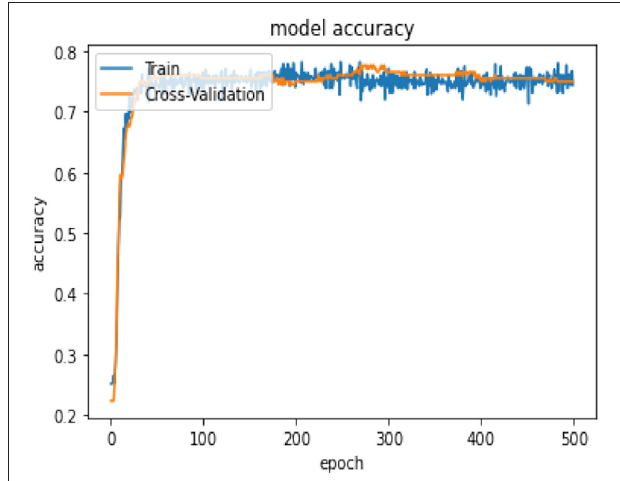
FIGURE 14 | ANN model accuracy-the UAE.